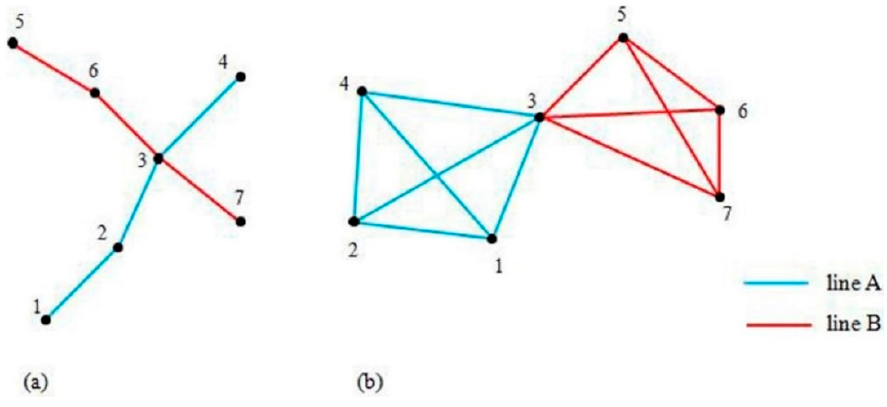
Figure 4. ( a ) Explanation of space L ; ( b ) explanation of space P .